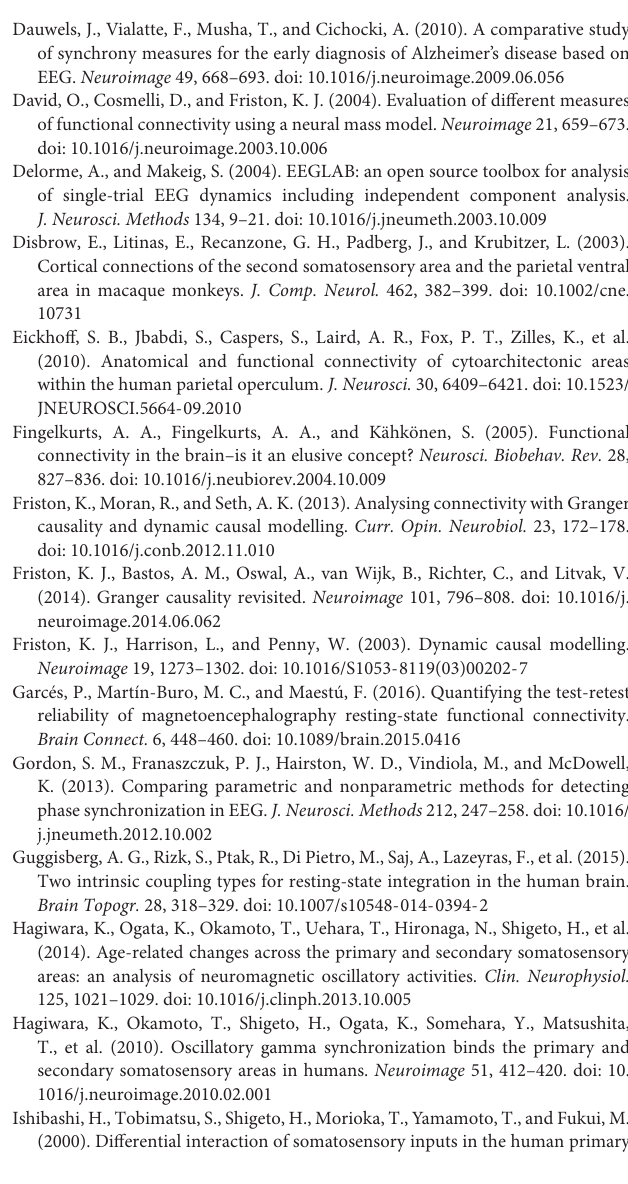
FIGURE S1 | Processing pipeline for investigating descriptive statistics of the functional connectivity measures. The mask images for stimulus-induced FCs and for prestimulus FCs were defined using the grand-averages of double-thresholded FCs (dFCs). FC, functional connectivity; nMEANs, means of normalized FC values; (n)CVs, coefficients of variance of (normalized) FC